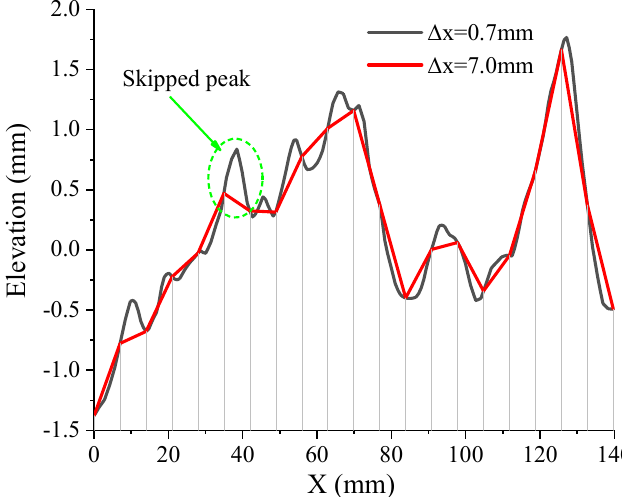
Figure 7. Profiles of L1 with different sampling intervals.